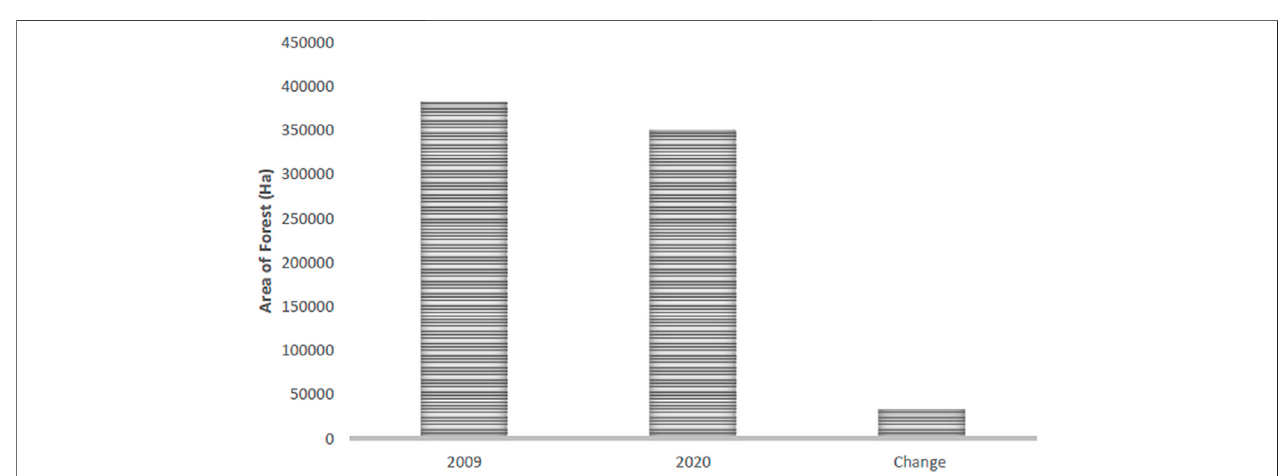
FIGURE 4 | Change in the forest area from 2009 to 2020.